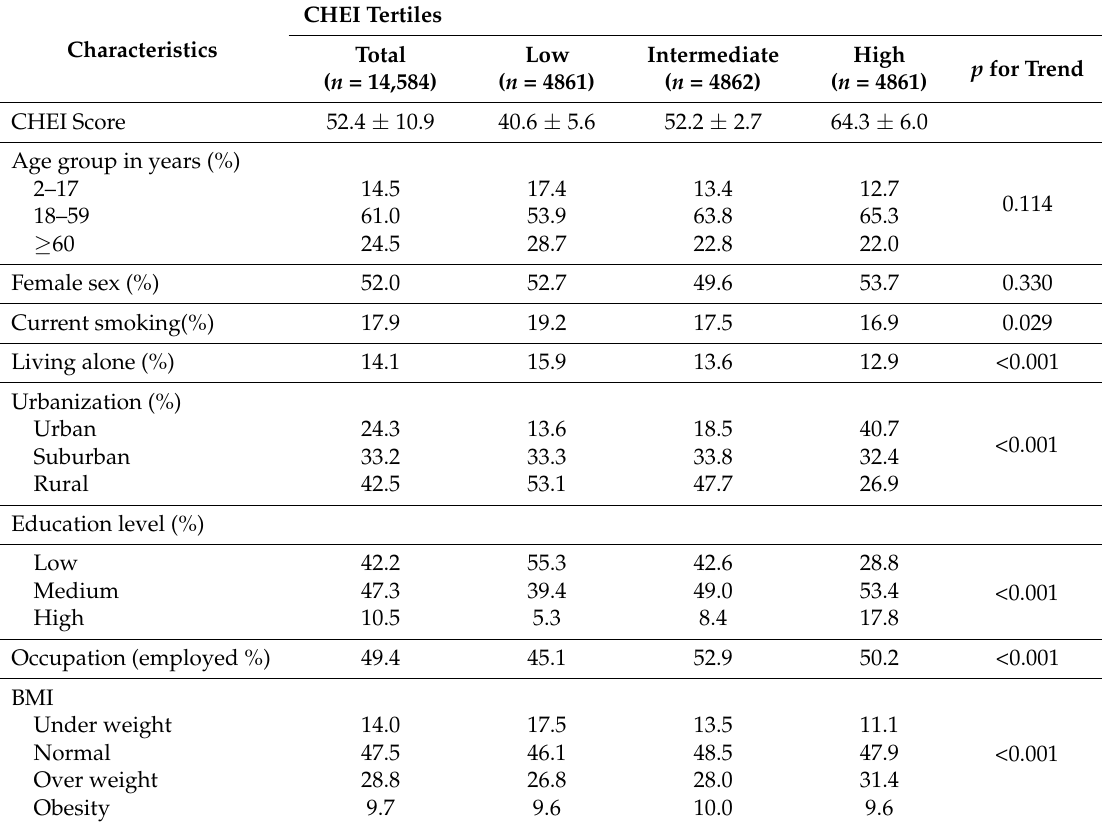
Table 4. Characteristics of participants in tertiles a of CHEI